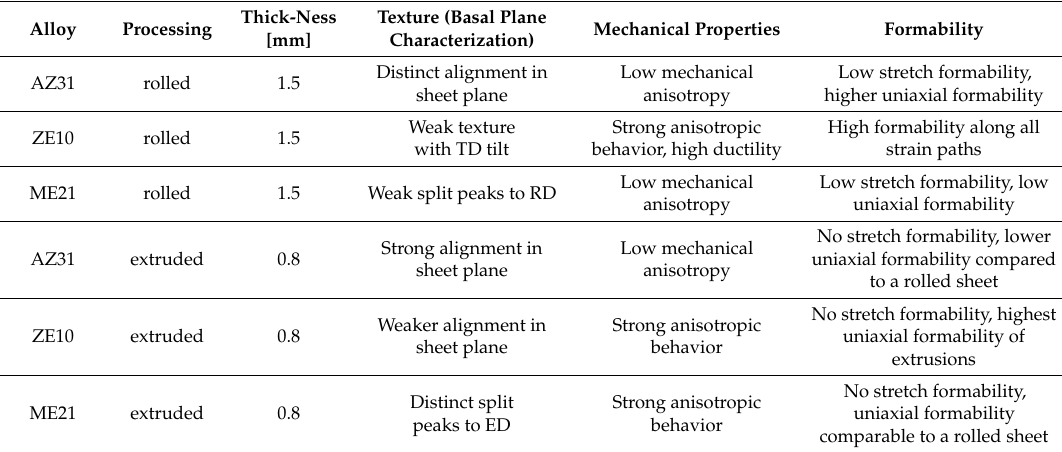
Table 3. Overview of the main findings from a microstructural analysis, mechanical analysis, and examination of the formation behavior of the six sheets of this